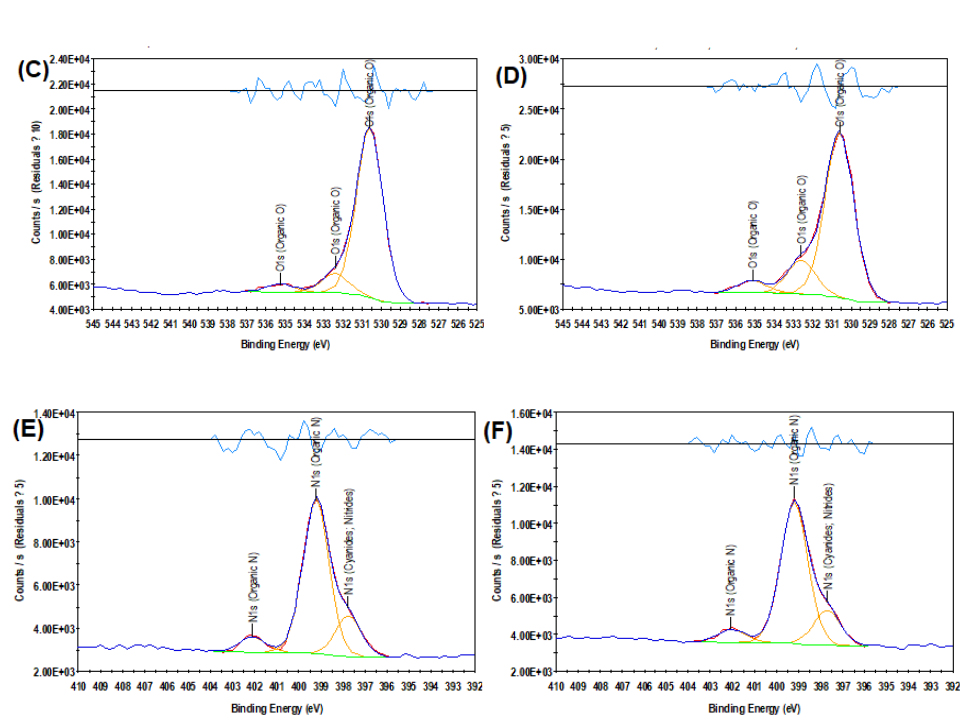
Figure 3. C 1s spectra of the unmodified membrane ( A ), C 1s spectra of the modified membrane ( B ), O 1s spectra of the unmodified membrane ( C ), O 1s spectra of the modified membrane ( D ), N 1s spectra of the unmodified membrane ( E ), N 1s spectra of the modified membrane ( F ).